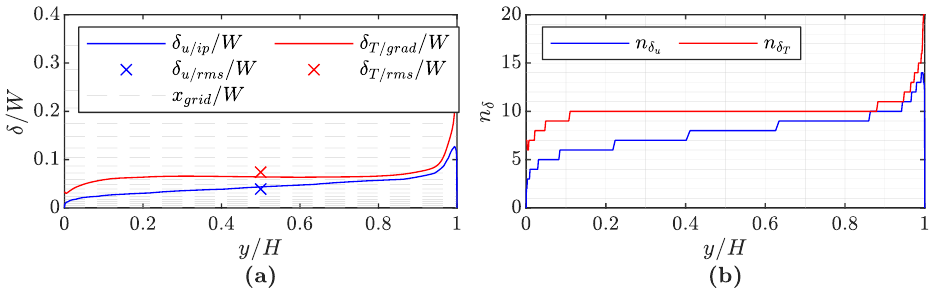
Figure 7. Structure and spatial resolution of the boundary layer: ( a ) thickness of the velocity and temperature boundary layer with the indicated wall-normal mesh resolution x grid and ( b ) the number of cells in the velocity and temperature boundary